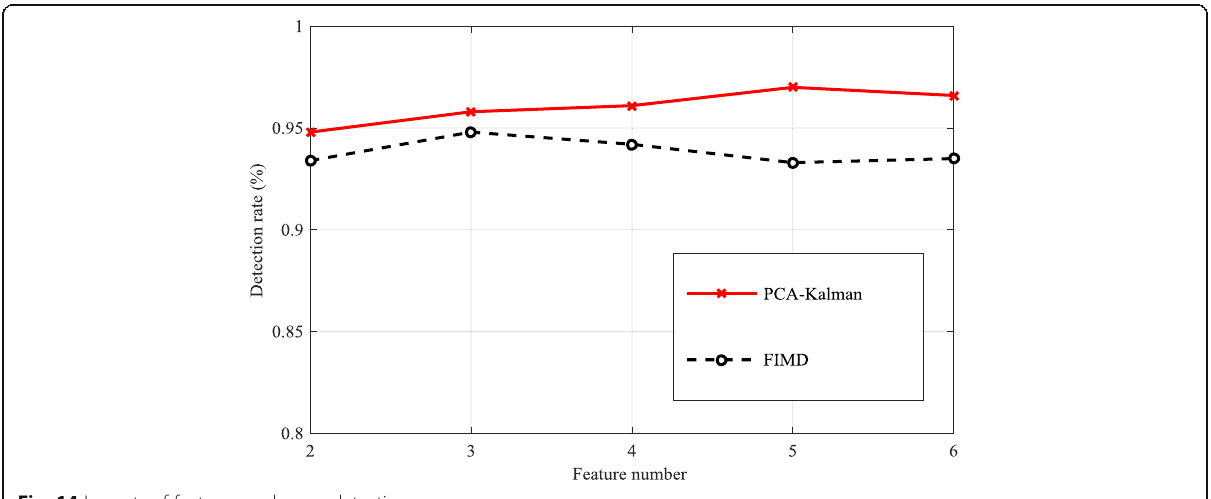
Fig. 14 Impacts of feature number on detection accuracy